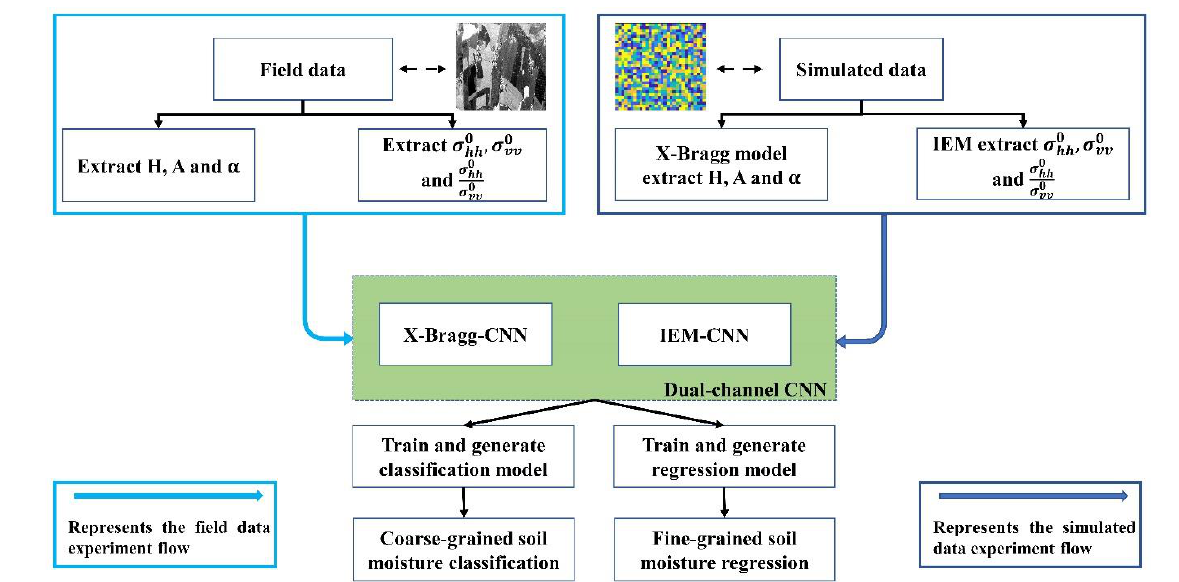
Figure 1. Overall flowchart of our proposed soil moisture inversion method.